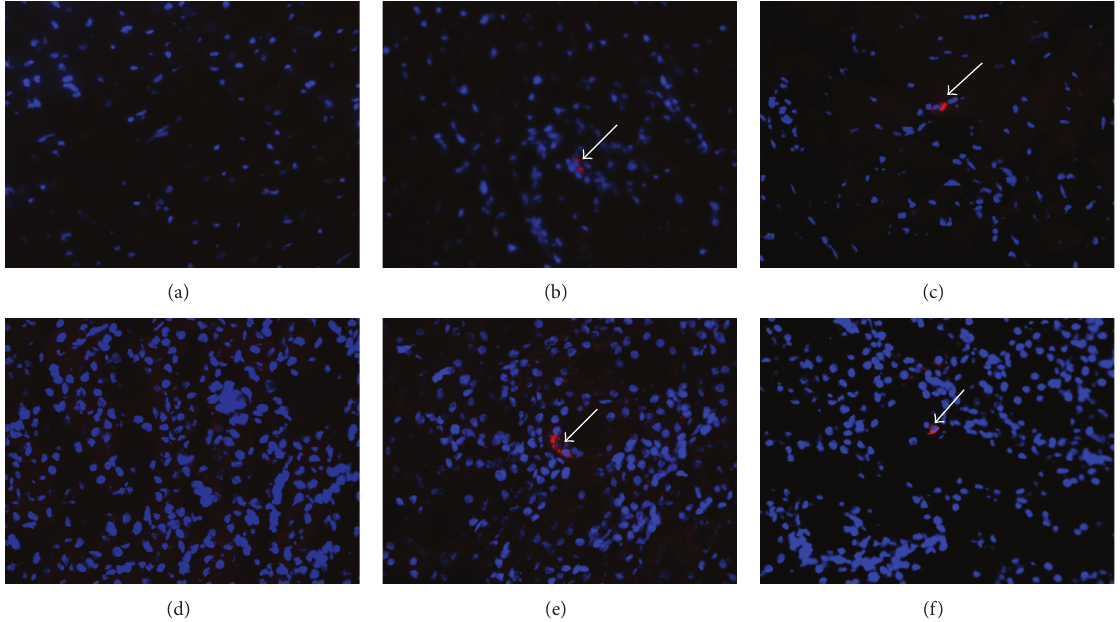
Figure 7: Detection of transplanted cells. Photomicrography of hearts (top panels) and kidneys (bottom panels) from the saline (a, d), MSC (b, e), and pMSC (c, f) groups. DAPI staining in blue and CM-DiI staining in red. Magnification: 400x. White arrows indicate the transplanted